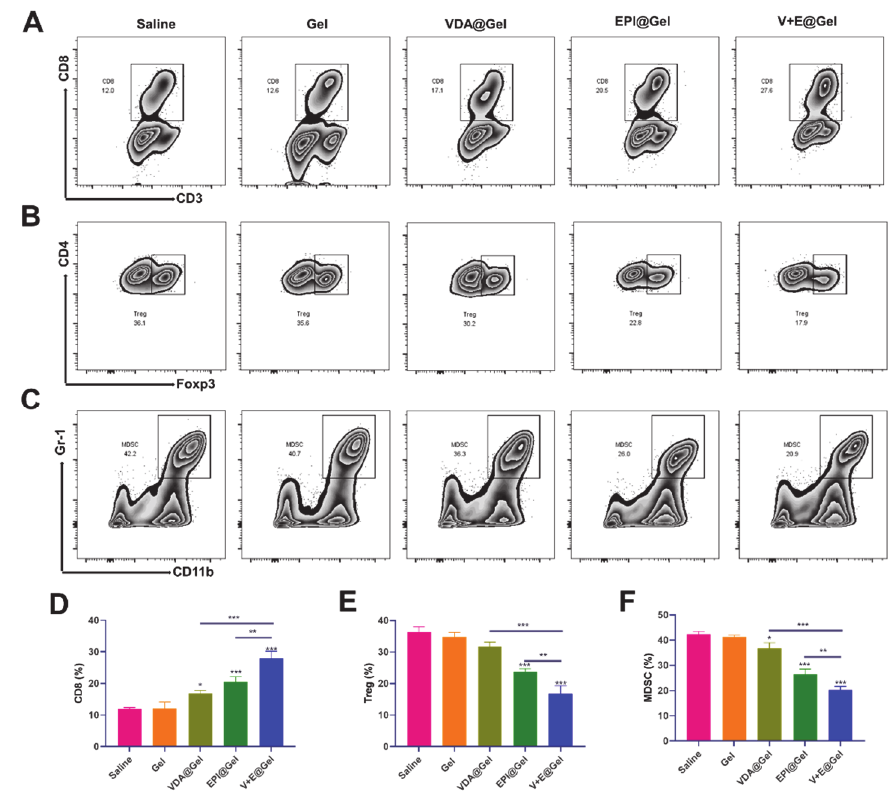
Figure 5. V+E@Gel induced robust immune reaction in tumor tissues. ( A – C ) Flow cytometric analysis and ( D – F ) quantitative analysis of CD8 + T cells after gating on CD3 + CD8 + cells, Treg cells after gating on CD4 + FOXP3 + cells, and MDSCs after gating on Gr-1 + CD11b + cells. All data are shown as mean ± S.D. ( n = 3). * p < 0.05, ** p < 0.01, and *** p < 0.001 vs. Saline.